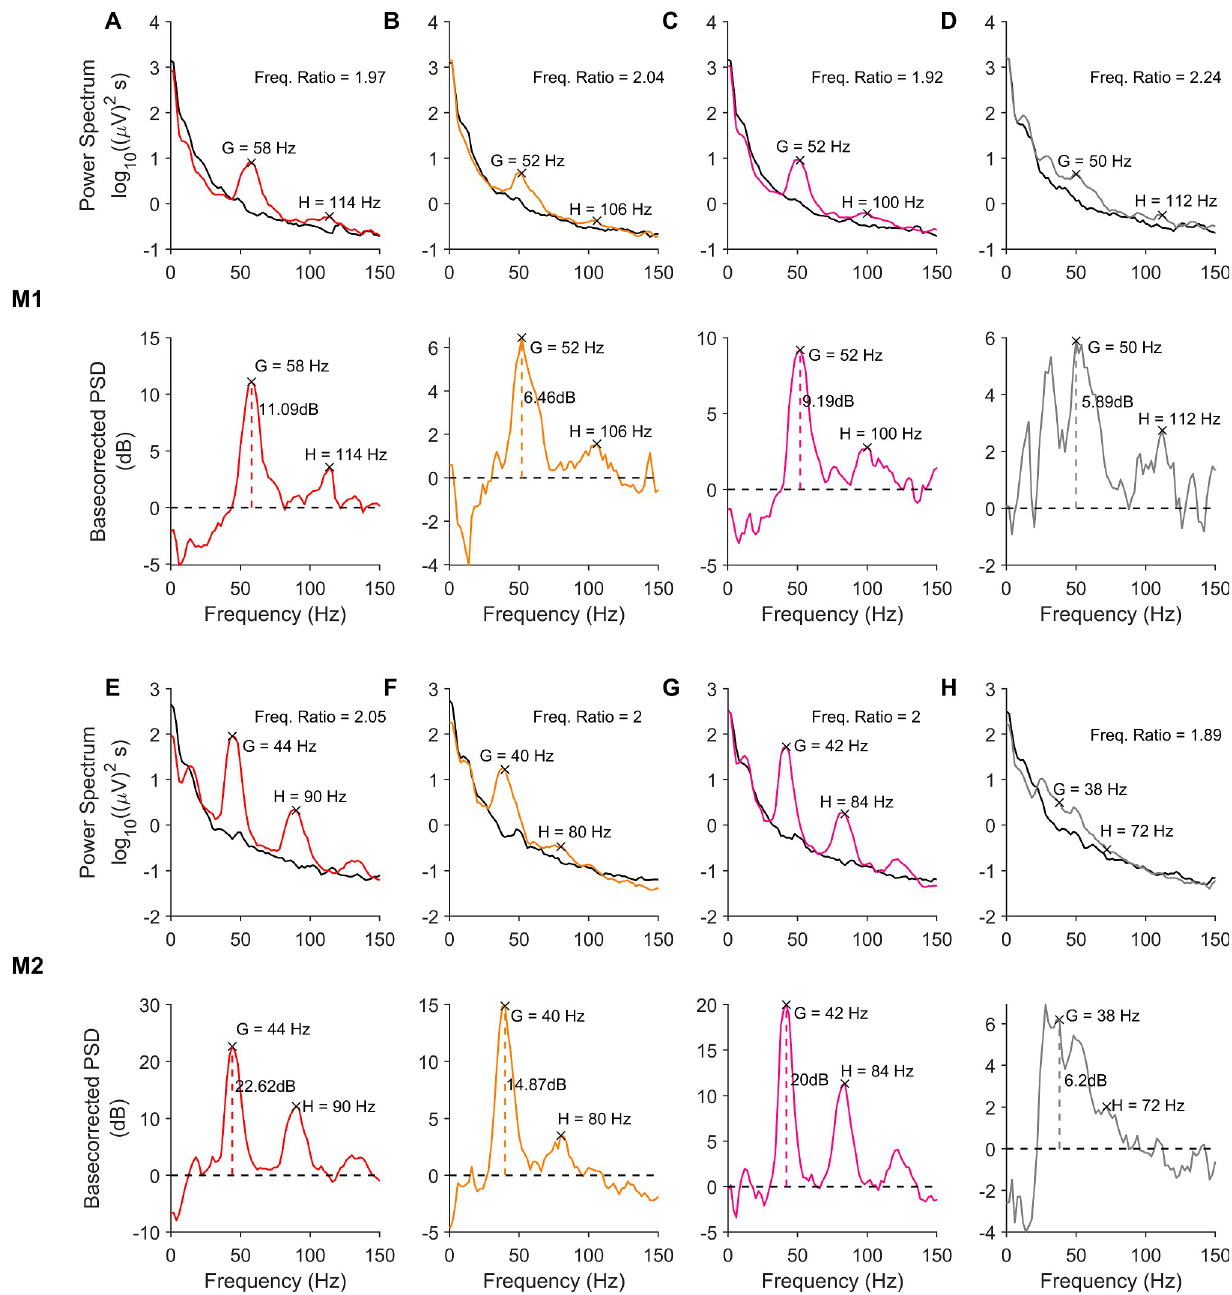
Fig 1. Visual Stimulation induces narrowband activity in gamma and its harmonic bands. (A-D, top row ) PSDs for baseline (-500 to 0 ms; 0 indicates stimulus onset) and stimulus (250 to 750 ms) periods for different stimuli, averaged across trials and electrodes, from monkey 1 (M1). The baseline PSDs are plotted in black, while the stimulus period PSDs are colored (corresponding to the hue presented) or grey (for fullscreen grating). (A-D, bottom row ) show the change in power (dB) in the stimulus period from the baseline, computed from the PSDs in the top row. The gamma power computed from the change in power spectrum is represented by vertical dashed line). The peaks in gamma range and the second bump activity are marked in each plot. (E-H) Same as A-D, for monkey